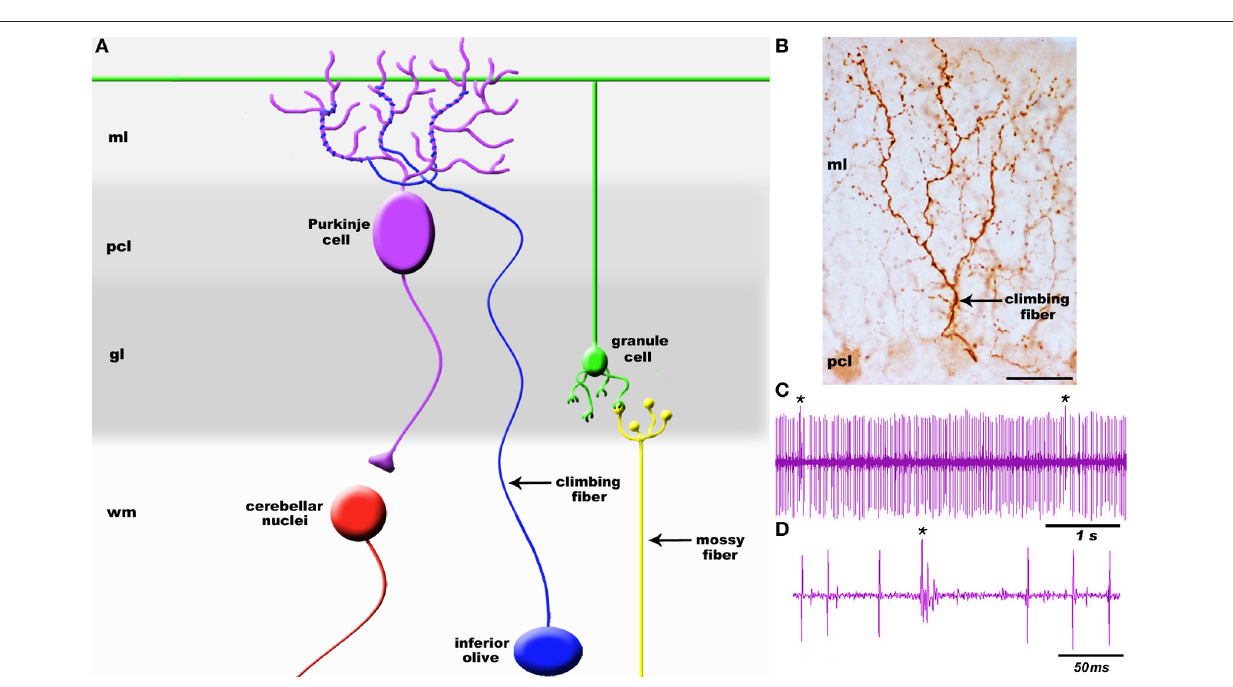
recorded in vivo . Recordings were performed in Ketamine/Xylazine anesthetized mice using 2–5M Ohm Tungsten electrodes (Thomas Recording, Germany). Signals were band-pass filtered at 300–5000 Hz, amplified with an ELC-03XS amplifier (NPI, Germany), and recorded with Spike2 (CED, England). (D) Higher power view of the recording trace illustrating the clear distinction between a climbing fiber complex spike (cs) and simple spike (ss) responses in Purkinje cells. Asterisk in panel (C) indicates a complex spike. The layers of the cerebellum are indicated as molecular layer (ml), Purkinje cell layer (pcl), granular layer (gl), and white matter (wm). The cerebellar nuclei are located in the white matter. Scale bar in (B) = 25 μ